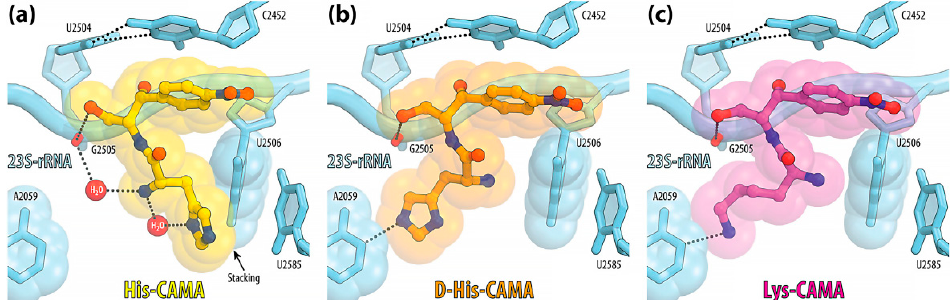
Figure 4. Side chain specific interaction of amino acid CAM analogs with the ribosome. Compound-specific H-bond interaction of His-CAMA ( 24 , His-CAM) ( a ), D-His-CAMA ( b ), or Lys-CAMA ( c ) with the nucleotides of the 23S rRNA are indicated with dashed lines. Stacking interactions of 24 are shown with the black arrow (the picture is published with the permission of the Elsevier, Order Number: 5033250763121).